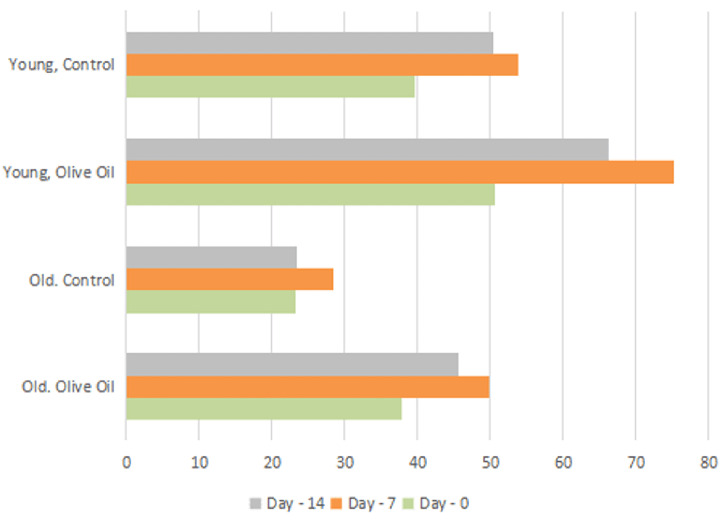
TGF-β1 levels (pg/ml) in gingival crevicular fluid of guinea pigs with tooth movement treated and untreated with olive oil.